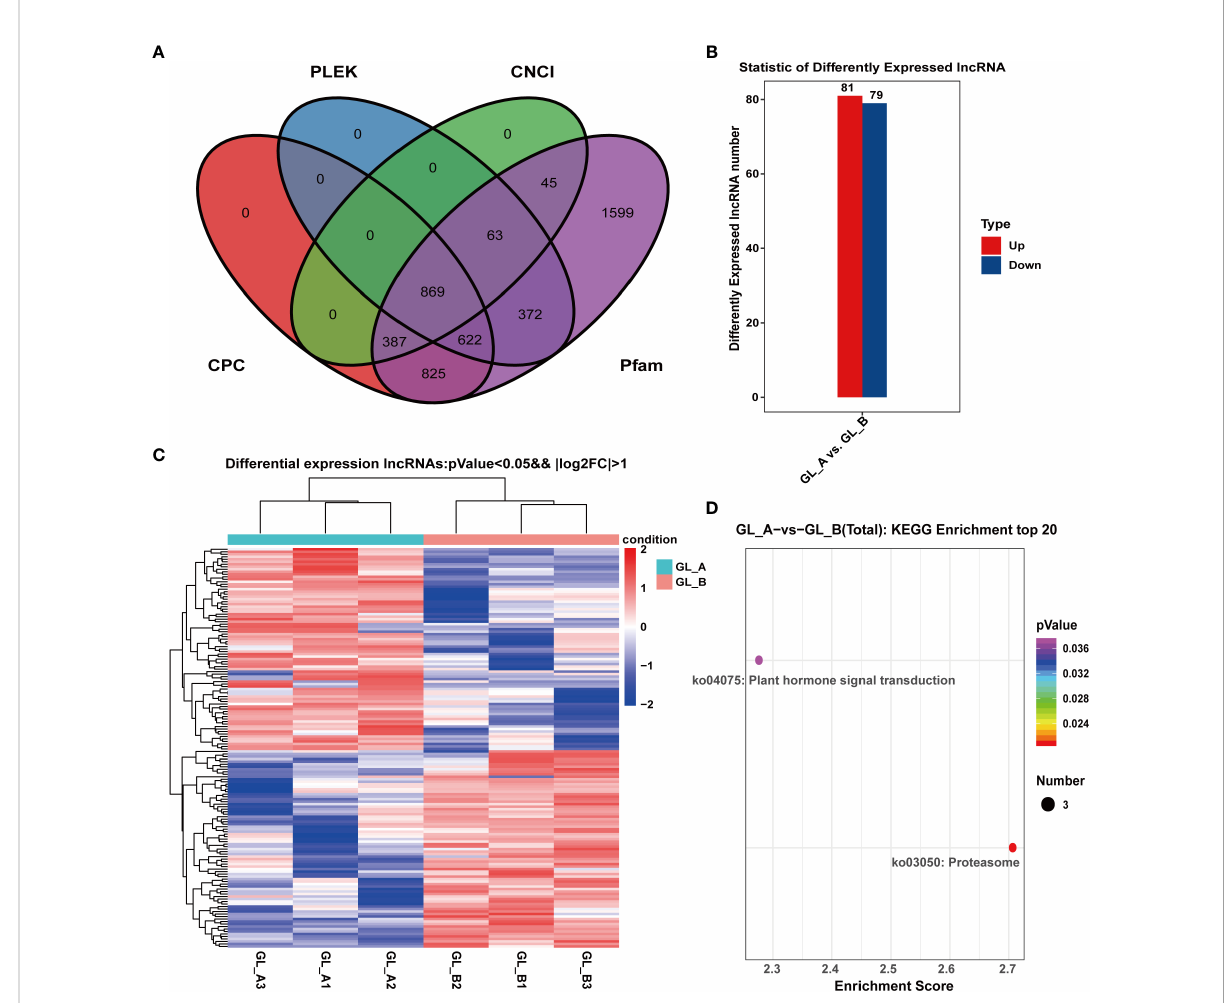
FIGURE 3 Screening and analysis of long-coding RNAs (lncRNAs) in the GA 3 -treated Sorghum ( “ Jitian 3 ” ) with under salt stress. (A) Coding potential analysis of lncRNAs based on four computational approaches (CNCI, CPC, PFAM, and PhyloCSF) by venny software (https://bioinfogp.cnb.csic. es/tools/venny/index.html). (B) Statistical analysis of the differentially expressed lncRNAs (DE-lncRNAs) in the GL_A and GL_B samples; Red dots represent upregulated DE-lncRNAs; blue dots represent downregulated DE-lncRNAs. (C) Heatmap analysis of DE-lncRNAs among the six lncRNA sequencing libraries; Red indicates upregulation, while blue indicates downregulation. (D) KEGG network enrichment analysis for all DE-lncRNA targets. Scatter plot of selected signifcantly targets pathway terms for the 160 diferentially expressed lncRNAs. Counts represent the numbers of DE-lncRNA